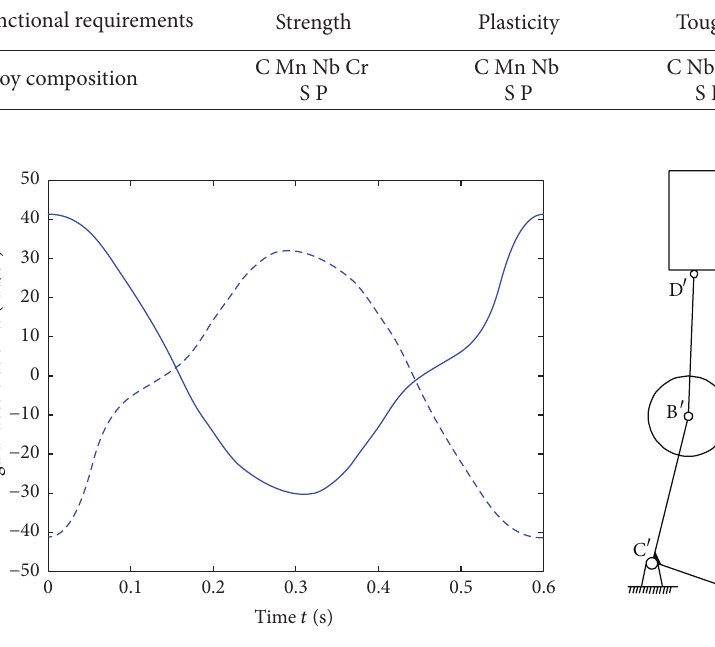
Figure 3: The angular acceleration of BD and B 󸀠 D 󸀠 .